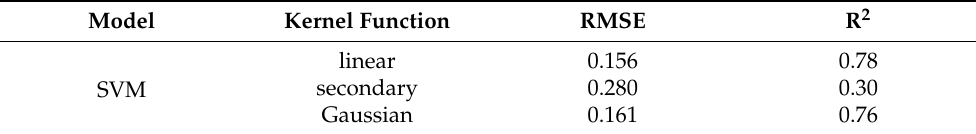
Table 8. Modeling results of soil nitrogen content with different kernel functions SVM. Model